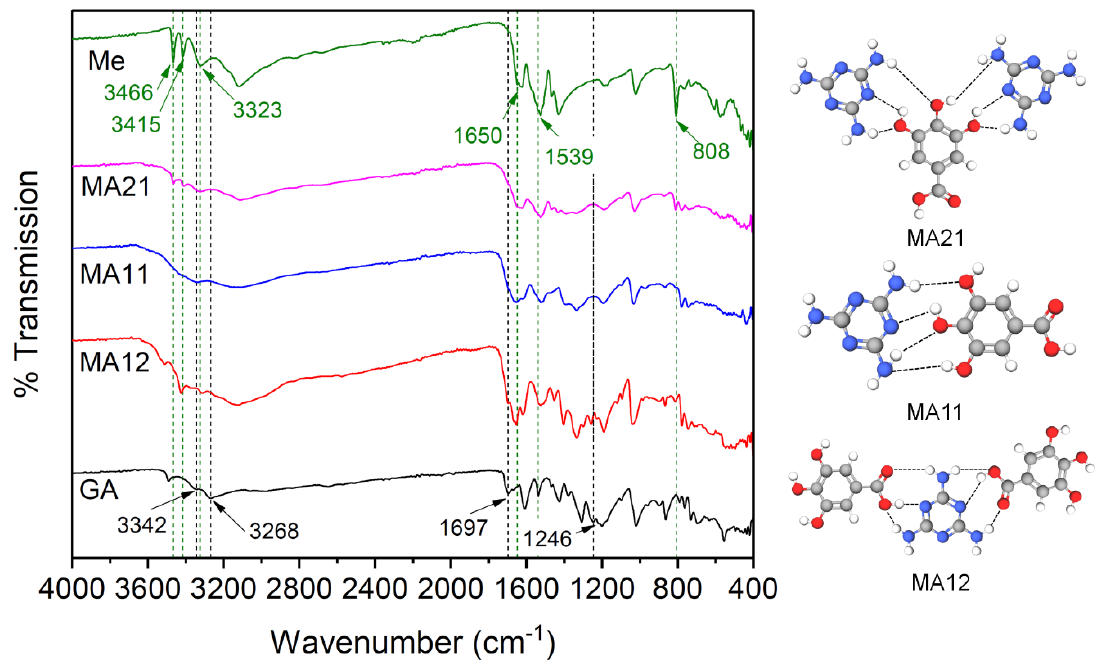
Figure 2. FTIR spectra of Me, GA, and MA complexes (green dash line for Me and black for GA) and the schematic illustration of possible H-bonding in MA complexes.